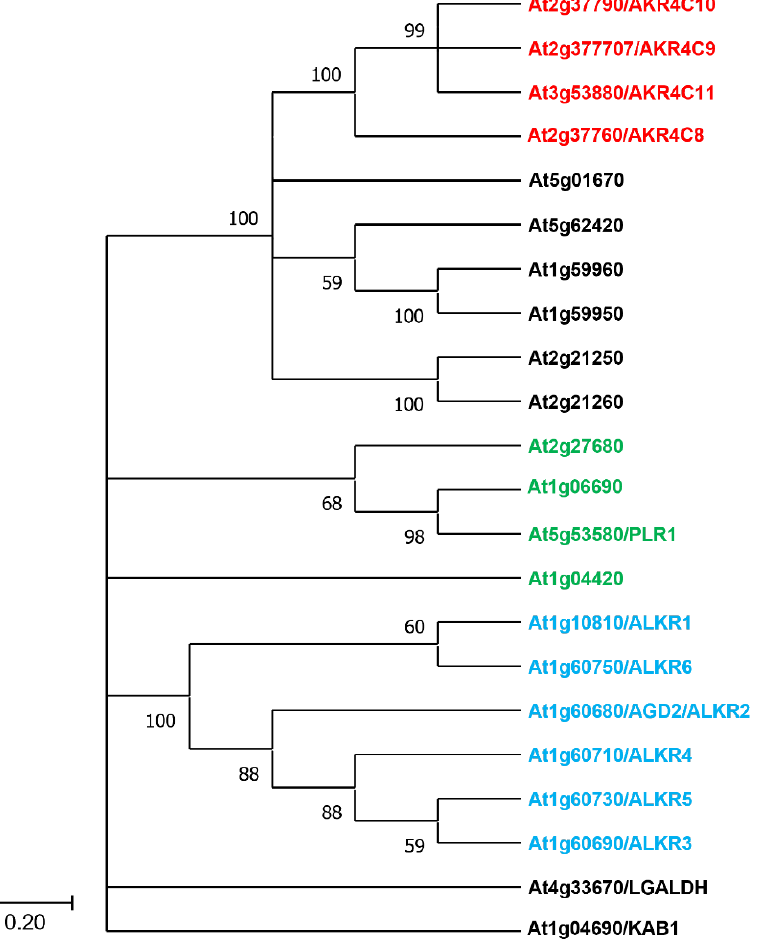
Figure 5. Phylogenetic tree of Arabidopsis AKR proteins. The phylogenetic tree was constructed by searching for aldo-keto reductases (PTHR11732) in the PANTHER database and using the MEGA 11 program with bootstrap test (1000 times) and the neighbor-joining method. Highlighted in red are the four members of the subclass 4C, while marked in blue are AKR proteins that lack the Lys residue in their catalytical tetrad. Green denotes AKR proteins that show an N -terminal extension, indicating they may localize to chloroplasts or mitochondria. In addition to the AGI identifiers, other names given to each AKR are shown.